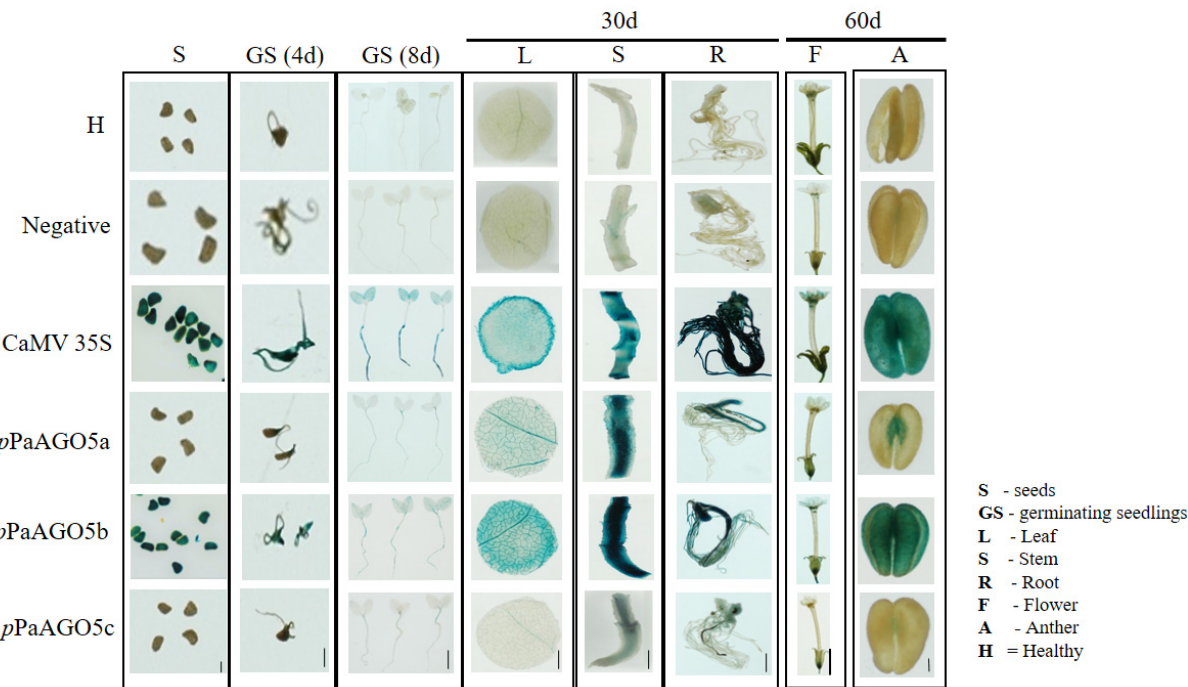
Figure 2. GUS histochemical staining in tissues of transgenic N. benthamiana. GUS expression driven by p PaAGO5a, p PaAGO5b, p PaAGO5c, CaMV 35S, and negative constructs. H represents healthy plants. As per the staining analysis, in CaMV 35S transgenic line, constitutive expression of GUS was observed in seeds, germinating seedlings, leaf, stem, root, flower, and anther. In the p PaAGO5a transgenic line, low expression of GUS was observed in germinating seedling, leaf, flower, and anther, moderate expression was observed in stem and root, and no expression was observed in seeds. In the p PaAGO5b transgenic line, higher expression of GUS expression was noticed in seeds, germinating seedlings, leaf, stem, root, flower, and anther. In the p PaAGO5c transgenic line, extremely low expression in germinating seedlings, leaf, and anther, low expression in the stem and root, and no expression in seeds have been observed. GUS activity was undetectable in healthy plants (H) and negative controls. The seeds, 4-and 8-day-old germinating seedlings, leaves, roots, stems of 30-day-old plants, and flowers and anthers of 60-day-old plants were incubated in GUS staining solution at 37 °C for 12 h. Scale bar of seeds: 0.1 cm; scale bar of anthers: 0.2 cm; the other scale bars: 1 cm.